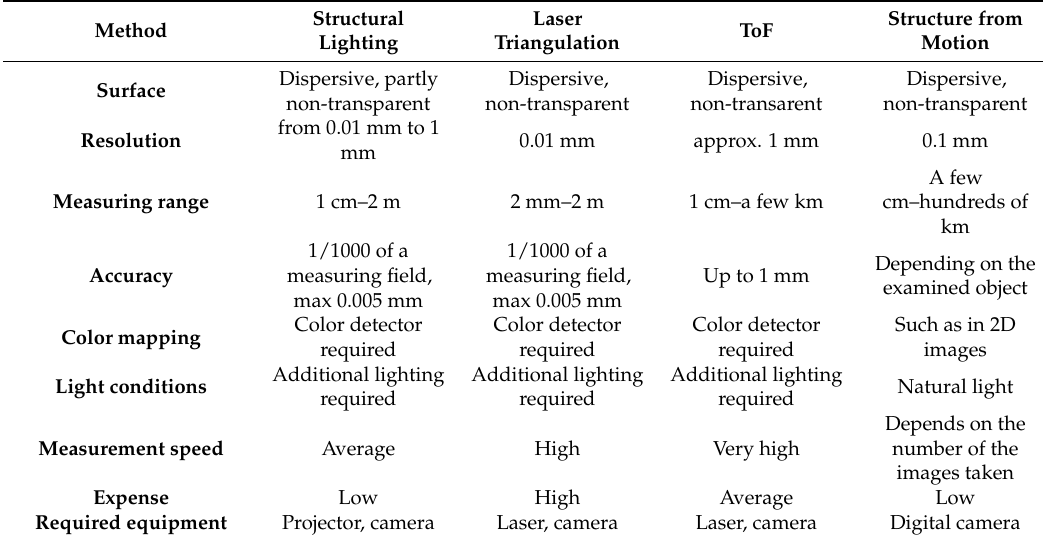
Table 1. Comparison of the most important optical parameters of the methods, which can be used for scanning the shape of a